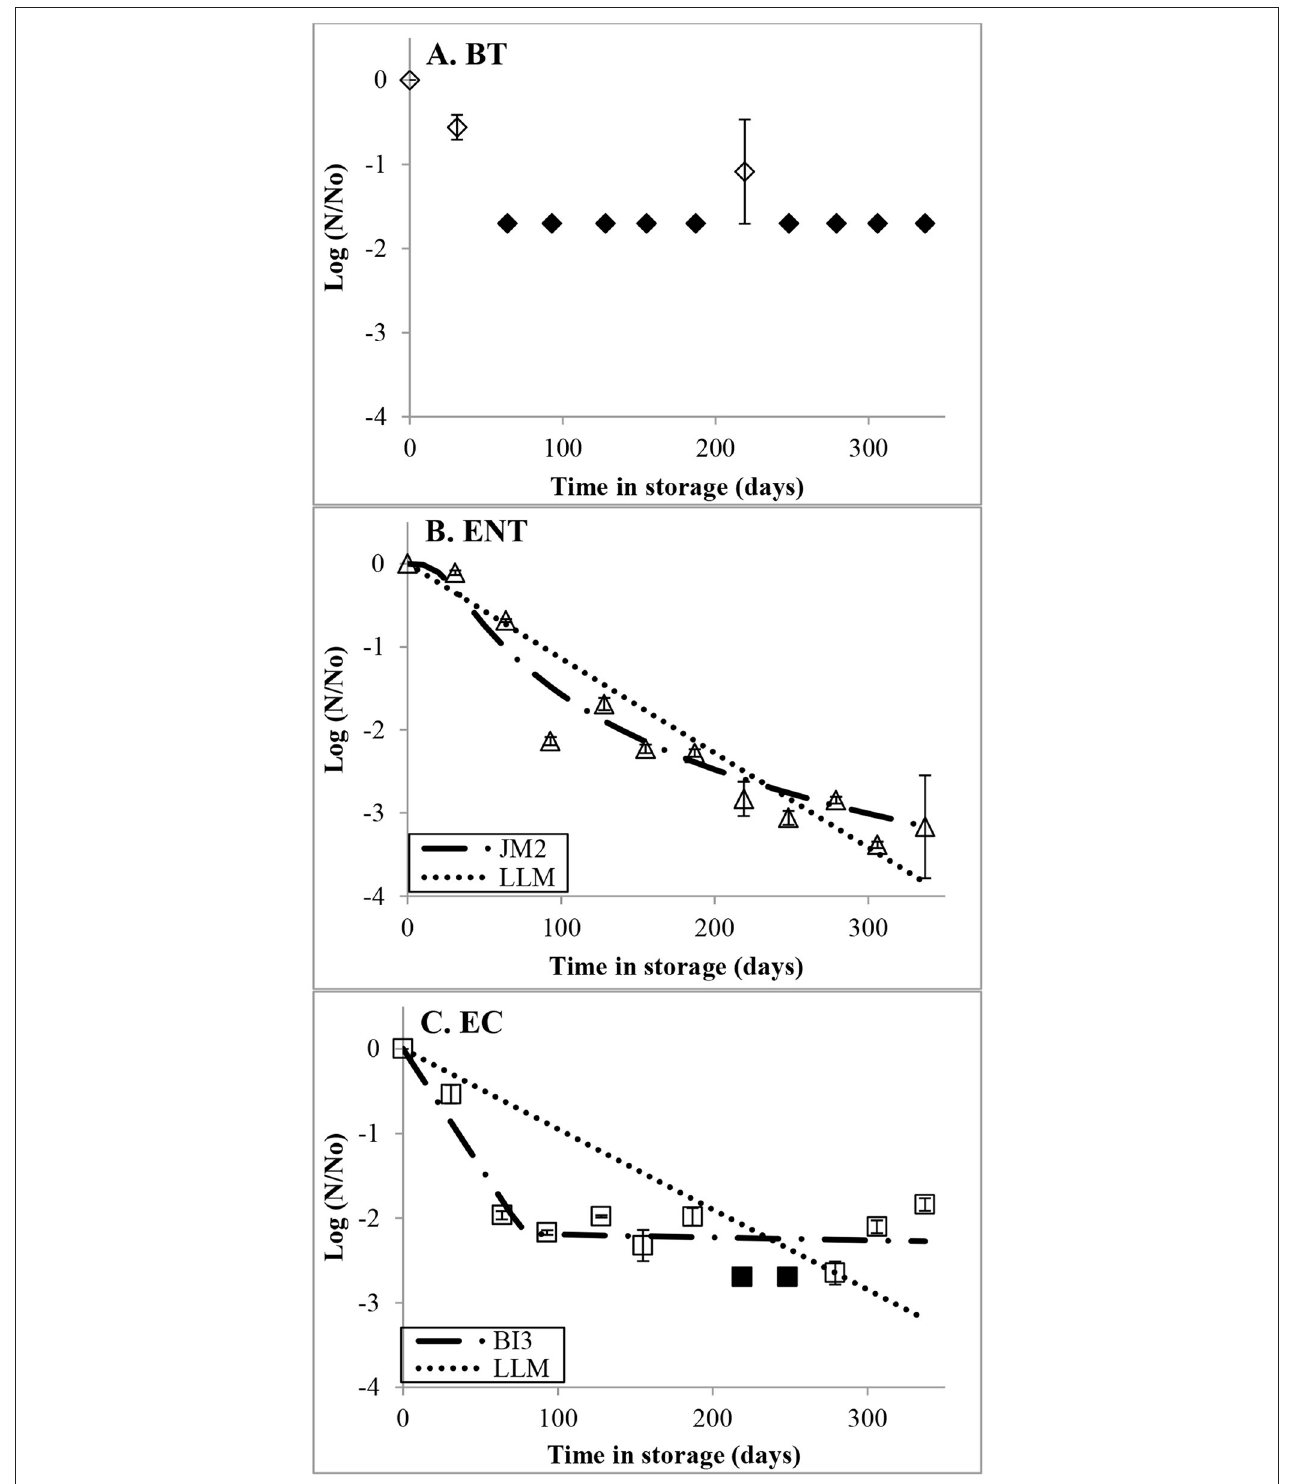
FIGURE 1 | The relative persistence of (A) Bacteroides thetaotiaomicron, BT; (B) enterococci, ENT; and (C) Escherichia coli , EC measured from microcosms containing sewage spike river water stored at 4 ◦ C for up to 337 days. Filled in data points illustrate the data that were below the detection limit and represent the indicator specific detection limit. Each data point represents the average relative persistence of three technical replicates. The error bars represent one standard error. The lines represent the following models: log-linear (LLM), biphasic log-linear (BI3), or log-logistic models (JM2).